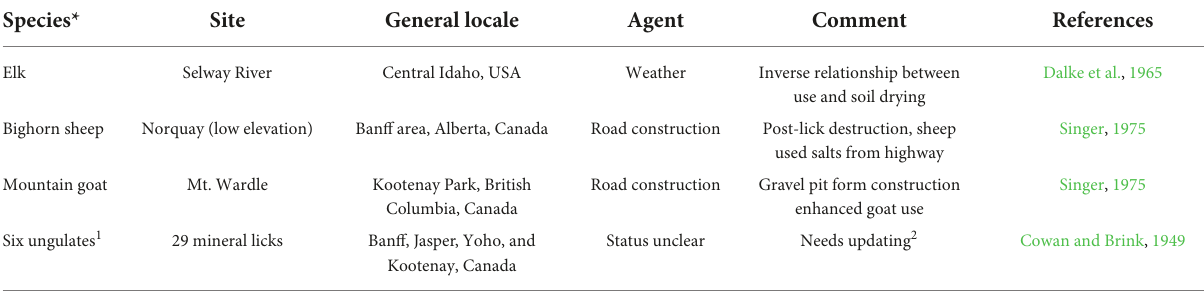
TABLE 2 Examples of mineral lick usage and change in lick usage due to anthropogenic alteration or local weather conditions. Species* Site General locale